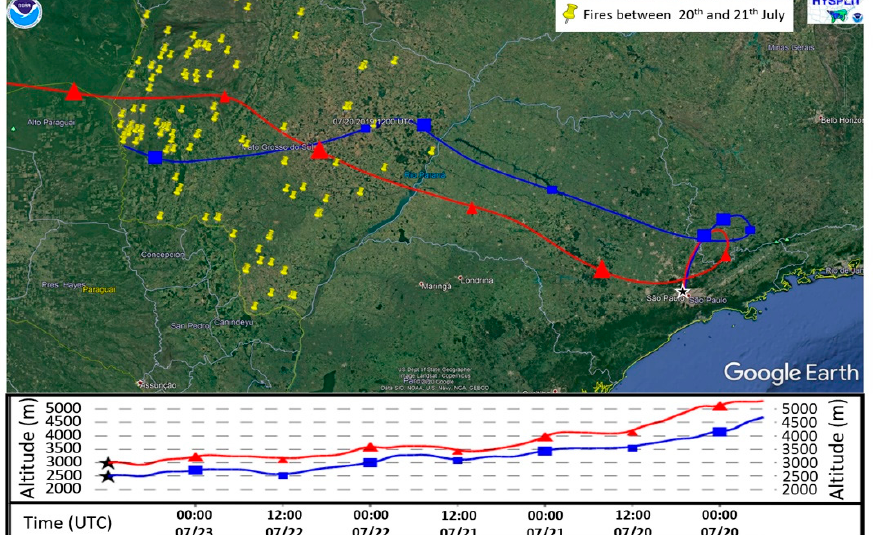
Figure 9. The 96-h backward trajectories generated from the hybrid single-particle lagrangian integrated trajectory model (HYSPLIT). The yellow points represent the wildfires detected by the satellites Geostationary Operational Environmental Satellite 16 (GOES-16) and Aqua in Brazil’s Midwest region between 20 and 21 July. The blue and red lines indicate the backward trajectories of the air parcels that arrived in the Metropolitan Area of São Paulo (MASP) at 2500 m and 3000 m, respectively. The map was generated using Google Earth.